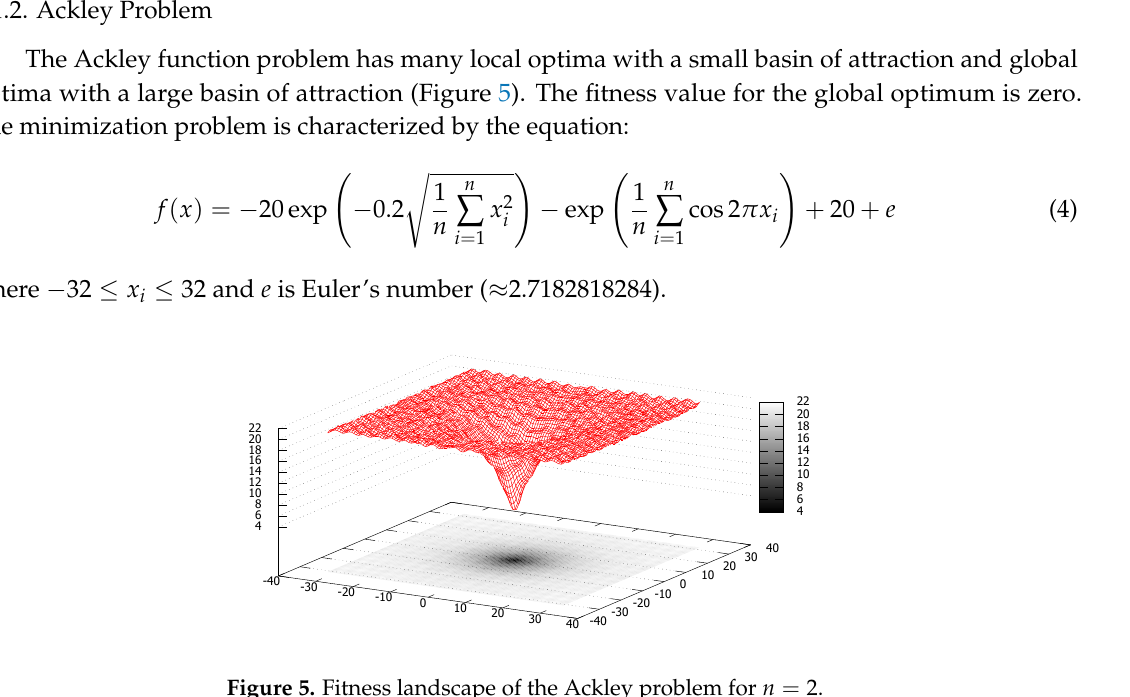
Figure 5. Fitness landscape of the Ackley problem for n =